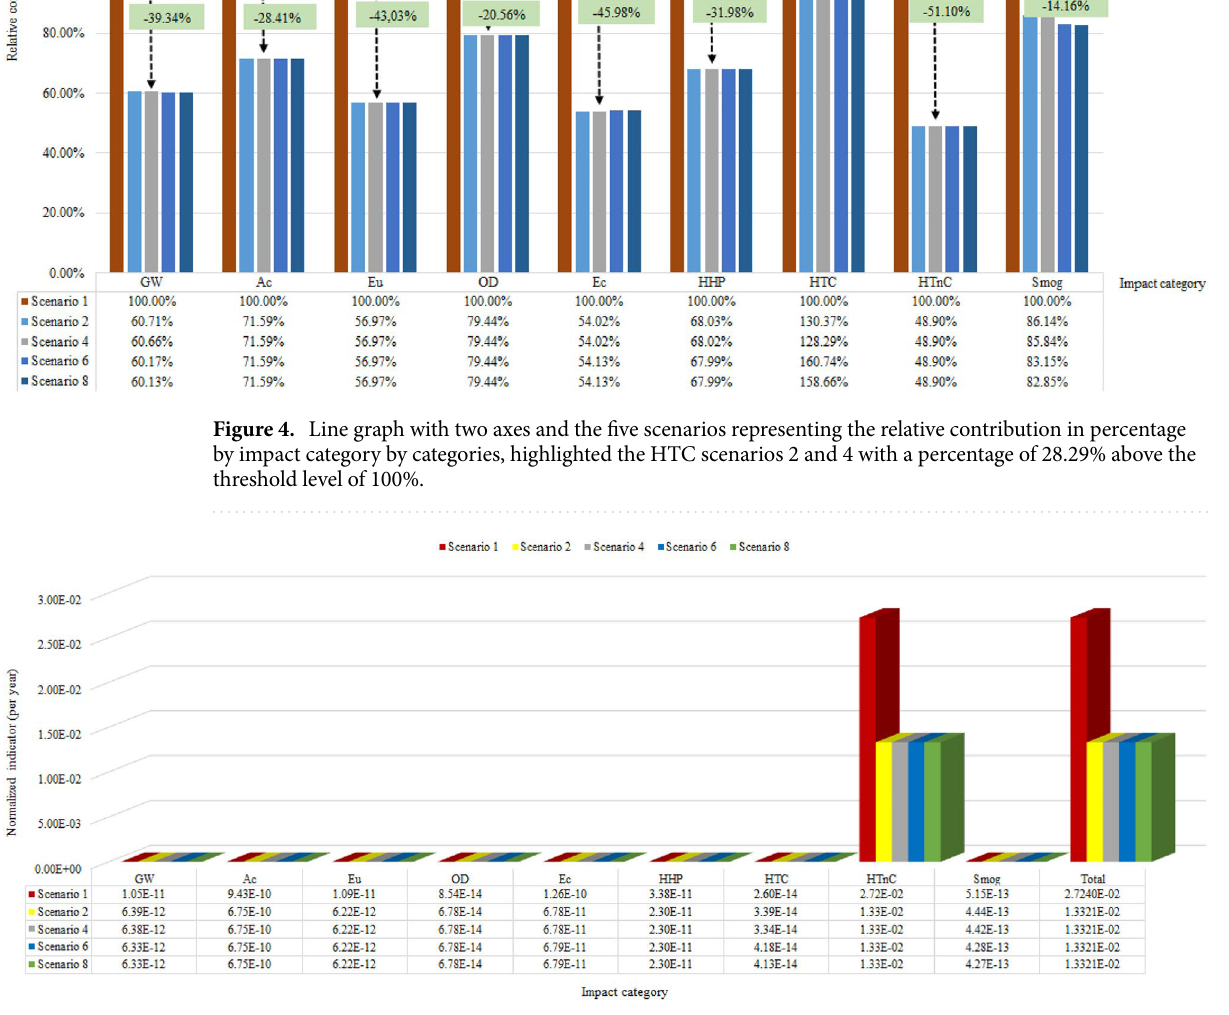
Figure 5. Line chart with two axes and five scenarios representing the normalized indicator per year by category of impact by all categories, being 51% greater than the total of scenario 1 in relation to the